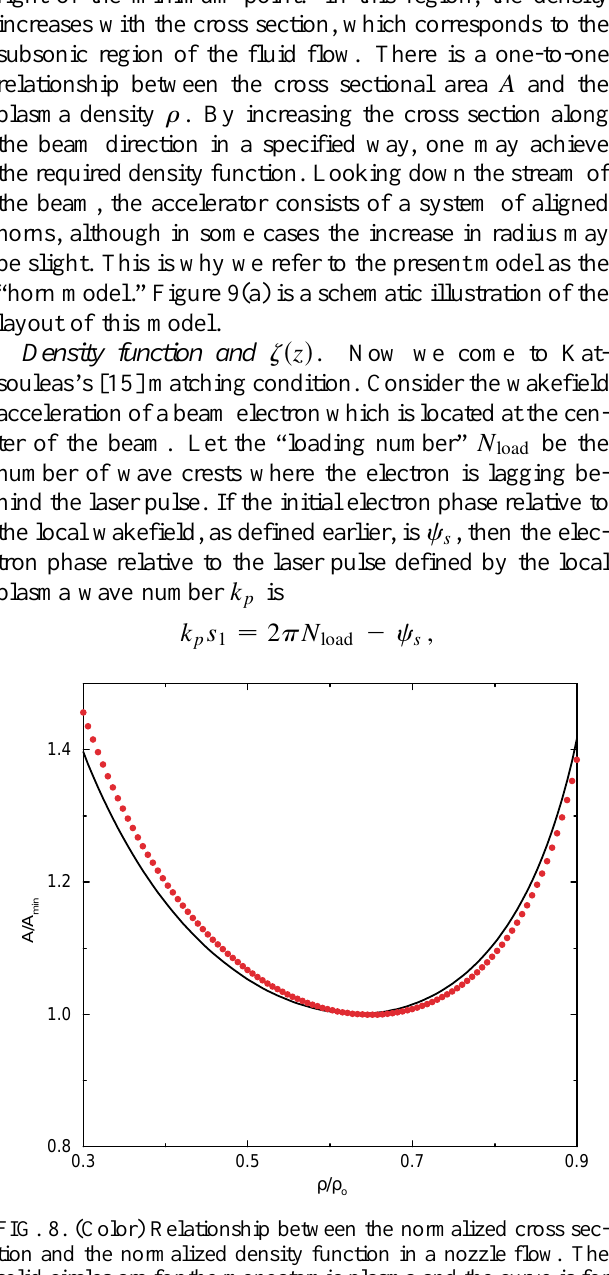
FIG. 9. The horn model. (a) Matching condition for syn- chronous acceleration for the case where c s (cid:1) 0 . (b) A sche- matic layout of the horn